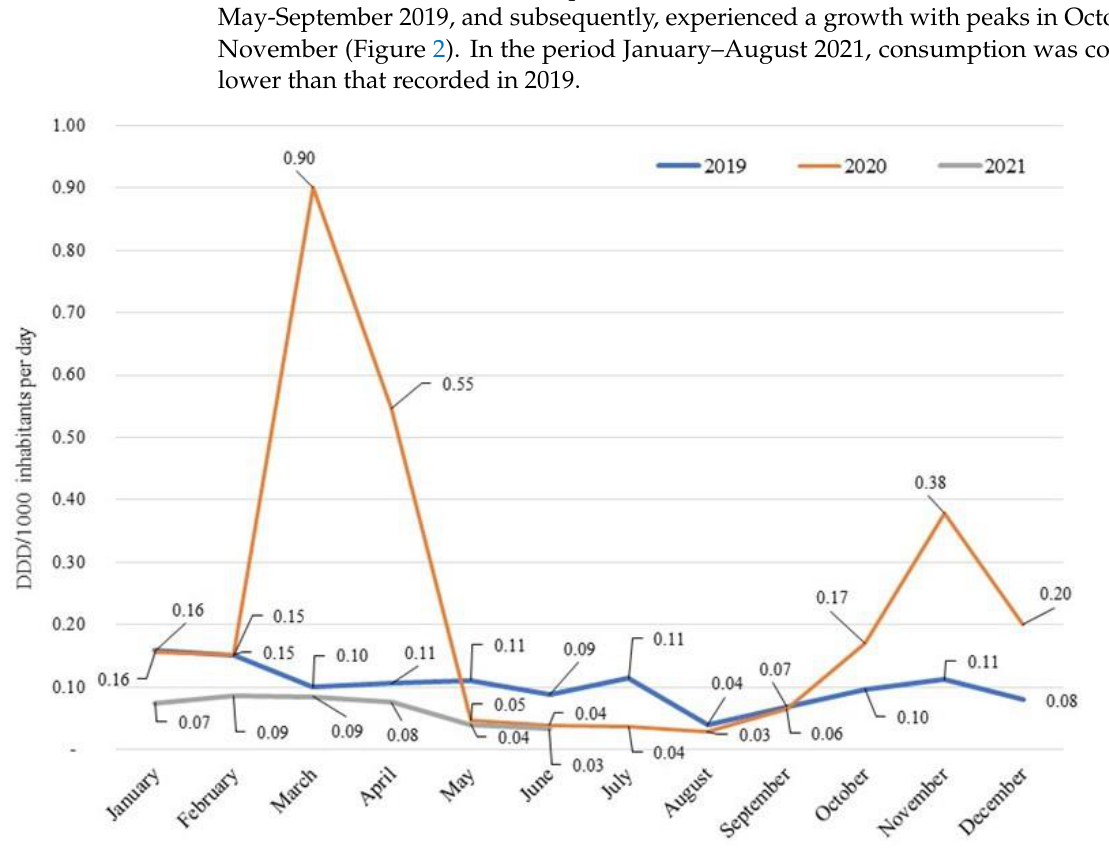
Figure 2. Consumption (DDD/1000 inhabitants per day) on a monthly basis of azithromycin in the hospital setting: 2019–2021 hospital setting: 2019 – 2021 comparison.